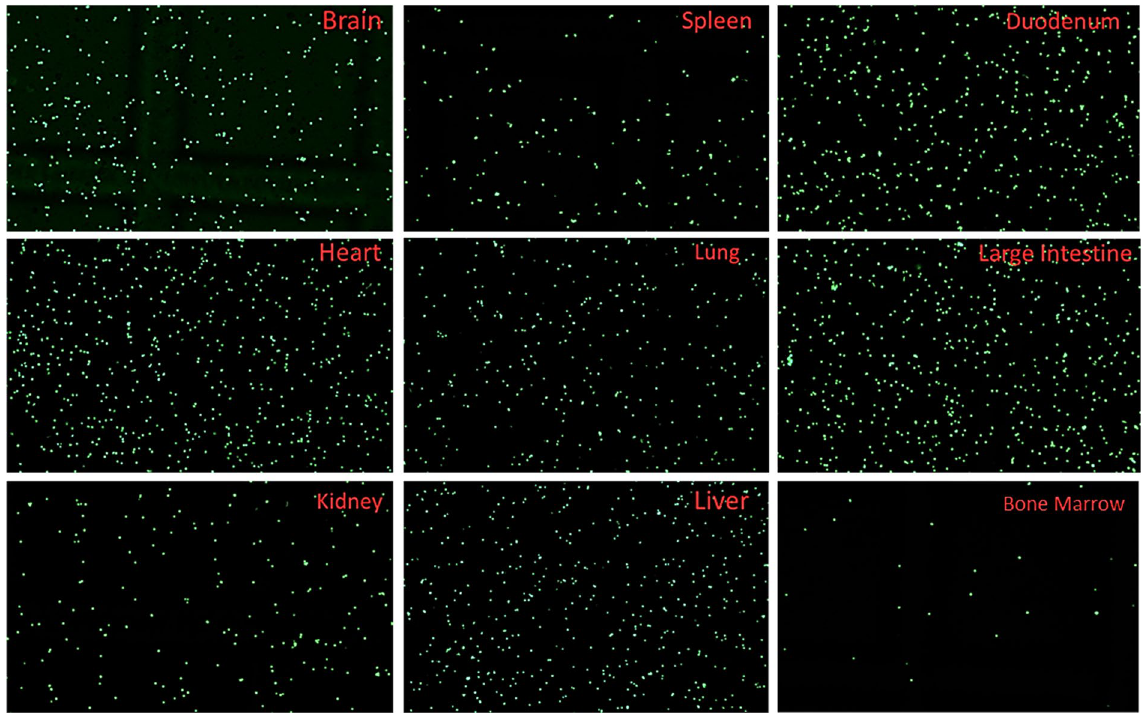
Figure 3. Representative images of single nuclei isolation from mouse tissues. Tissues were collected using needle biopsies and imaged at × 4 magnification. Green,